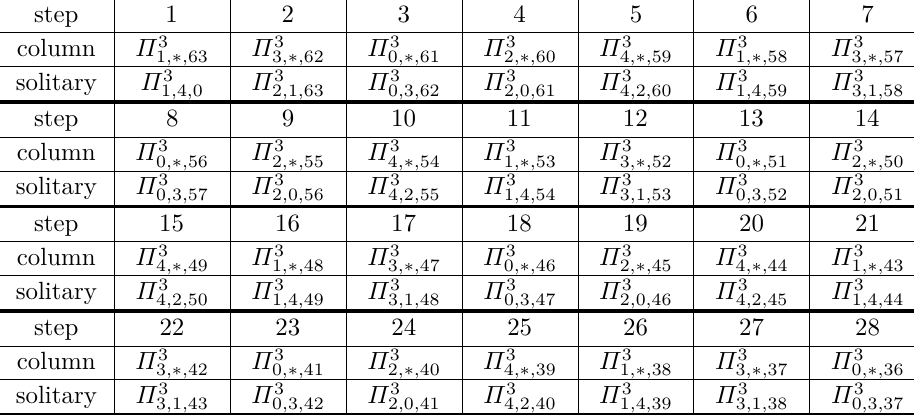
Table 4: Details about 173 constant bits (example starting from Π 3